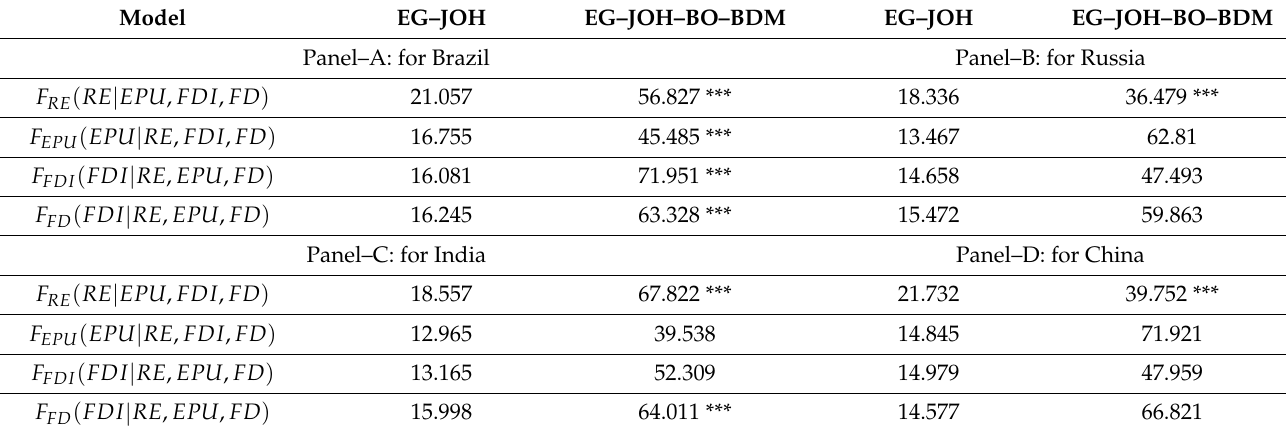
Table 7. Result of Bayer and Hanck combined cointegration